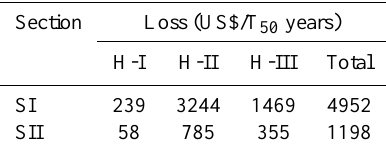
Table 6. Direct specific risk per kilometre of the road.